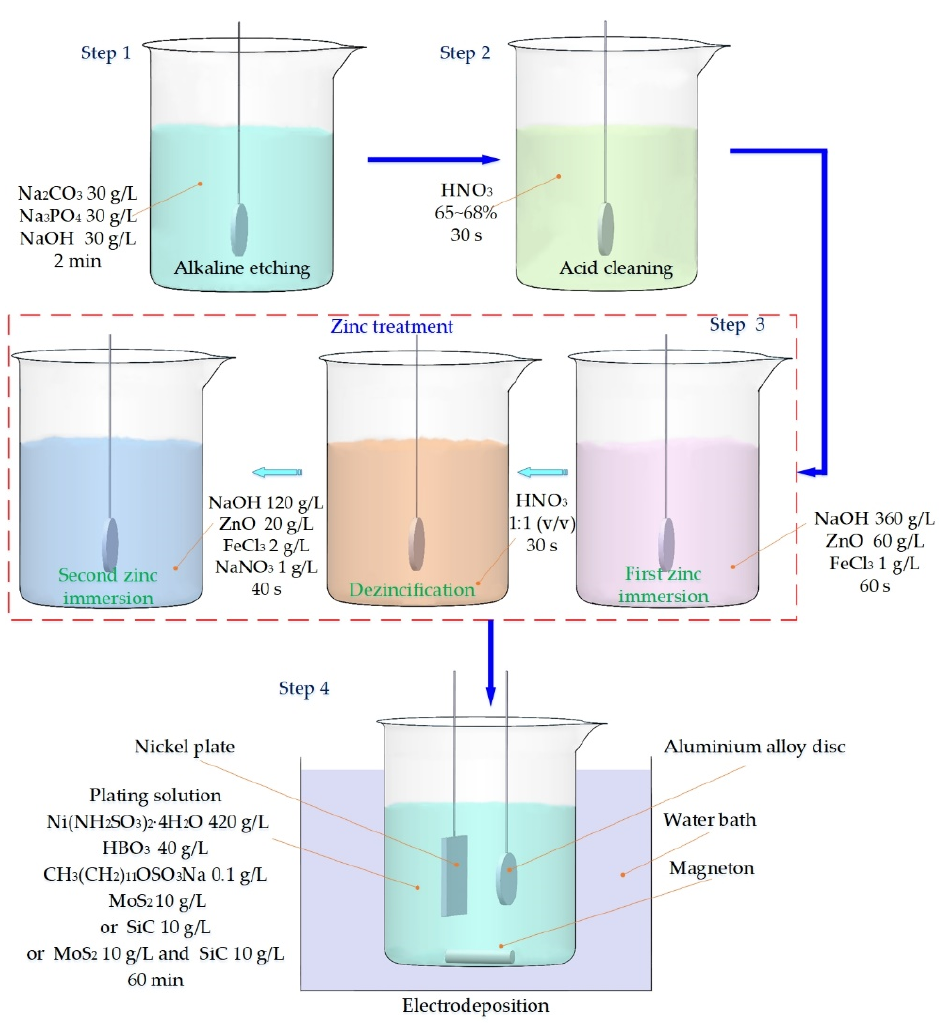
Figure 1. Flow diagram of the technological